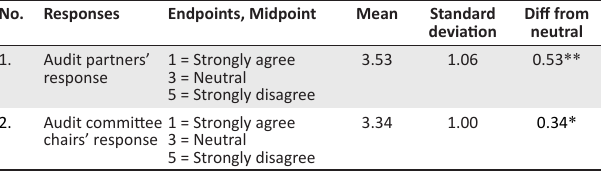
TABLE 1: Perspectives on transformation statistics. Statement: According to the Independent Regulatory Board for Auditors (IRBA), of the 4283 registered auditors in South Africa, 74.8% are white and only 10.5% are black Africans. Of the 353 audit partners signing off on listed company audits, only 9 are black African. Based on this, please provide your response to the following statement: The rate of transformation in the audit profession is